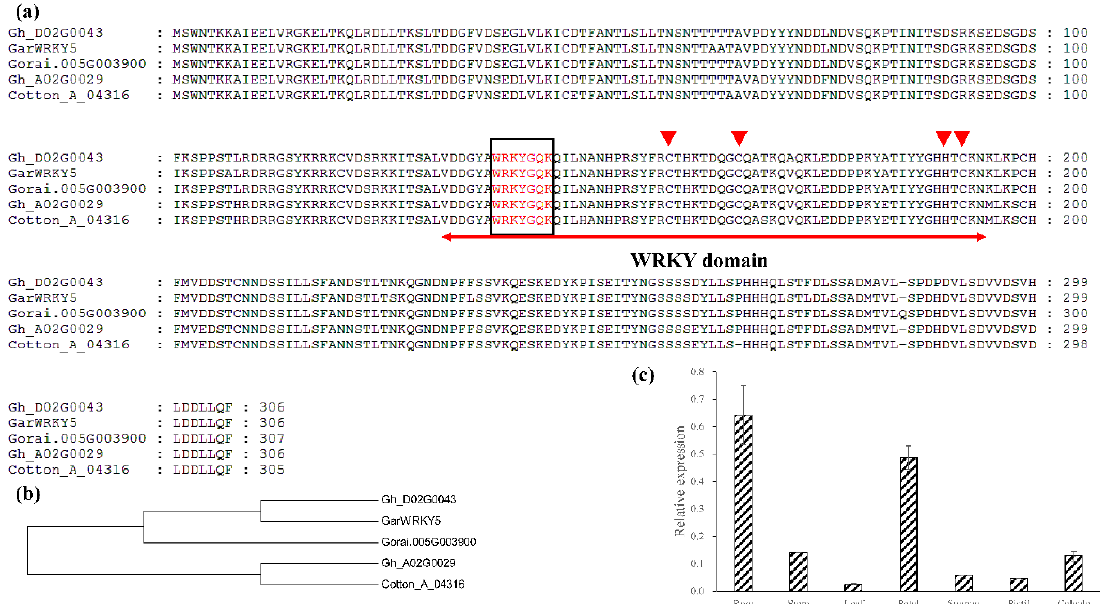
Figure 1. Structure, evolution, and expression of GarWRKY5. ( a ) Identification of the WRKY domain. The approximately 60-amino acid WRKY domain and C–X 7 –CX 23 –HXC-type zinc finger-like motif. The 60 amino acid WRKY domain was indicated by a red line and the conserved WRKYGQK sequence was black squares. The C and H residues of zinc finger domain were indicated by red triangles. ( b ) Phylogenetic analysis of GarWRKY5 between homologous genes from G. hirsutum (Gh_A02G0029 / Gh_D02G0043), G. raimondii (Gorai.005G003900), and G. arboreum (Cotton_A_04316). ( c ) The expression of GarWRKY5 in different tissues and organs from G. aridum . The relative expression levels were calculated with three biological replicates and three experimental replicates. Standard deviation (SD) was used to calculate the error bars.